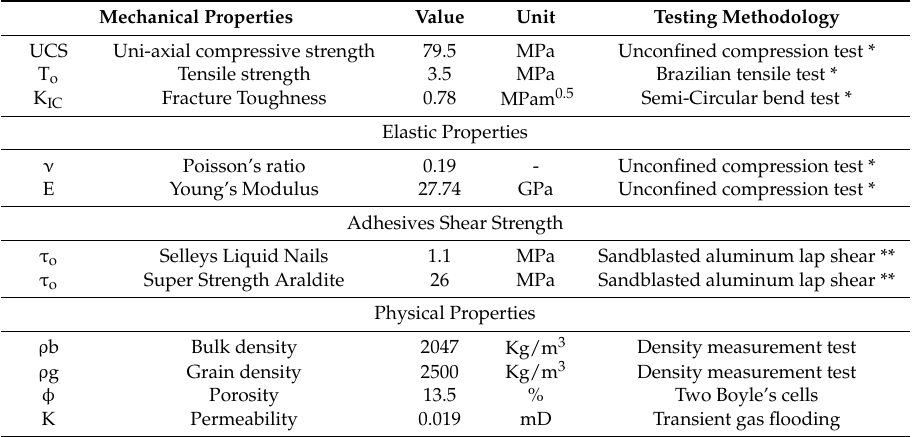
Table 1. Properties of the synthetic sample and the adhesives used for sample preparation.